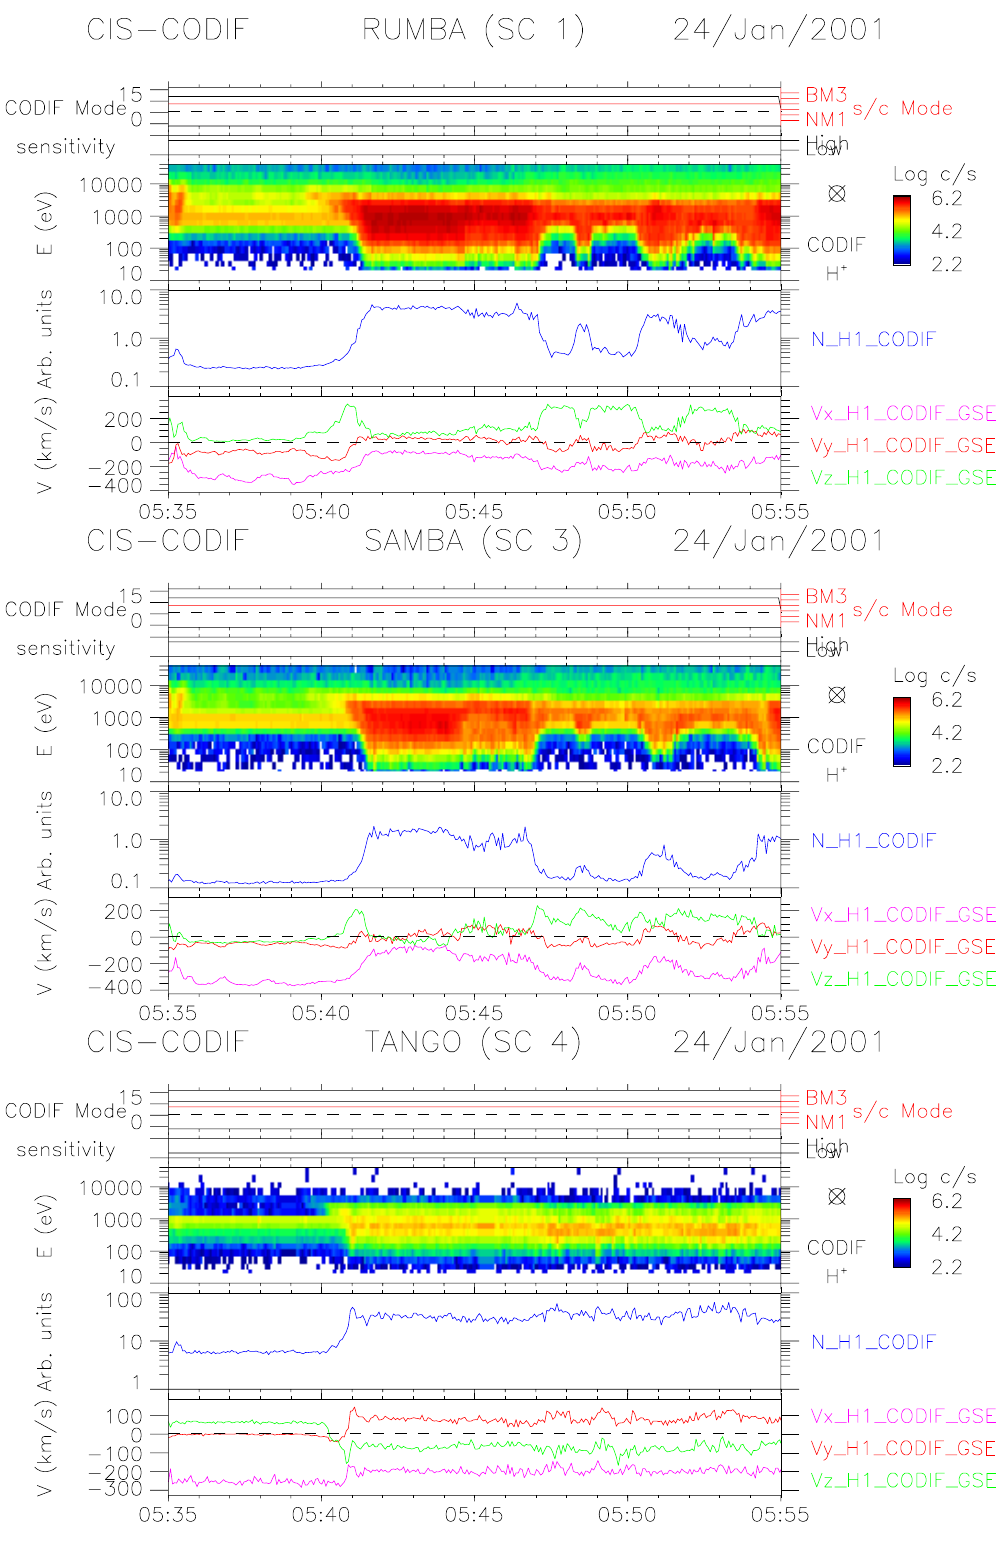
Fig. 32. CODIF measurements on board spacecraft 1, 3, and 4 on 24 January 2001, between 05:35 and 05:55UT. See Fig. 31 caption for the details of the